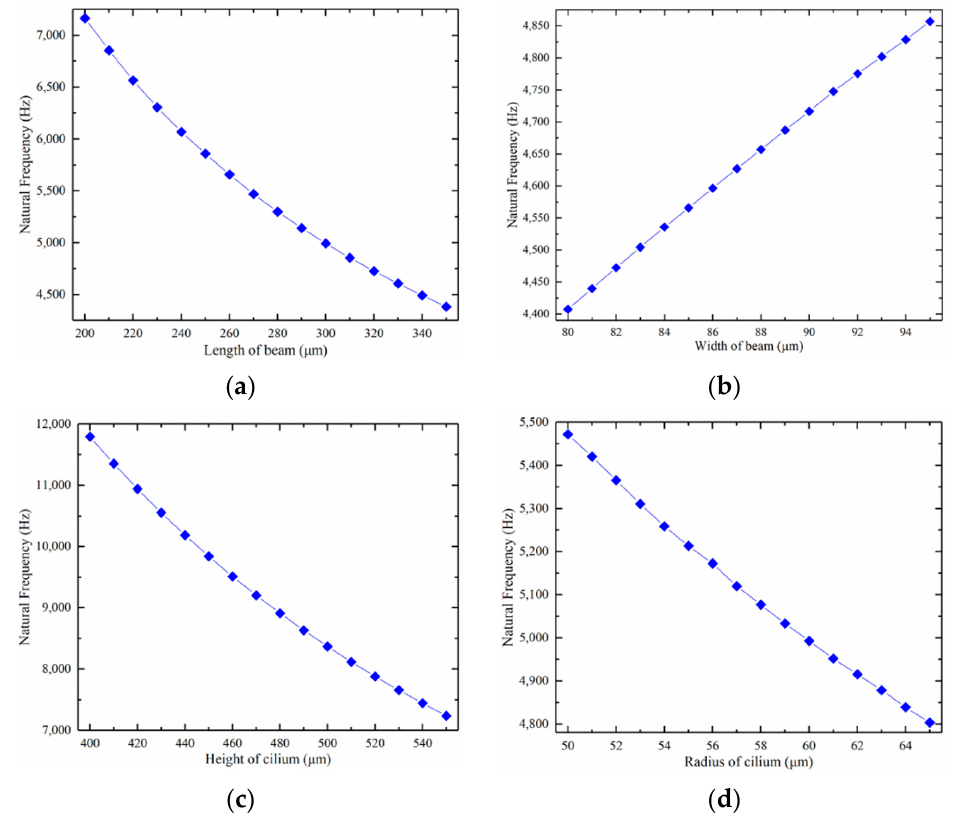
Figure 8. The impact of different structural parameters on the natural frequency: ( a ) beam length’s impact; ( b ) beam width’s impact; ( c ) cilium height’s impact; ( d ) cilium radius’ impact. Natural frequency is positively correlated with beam width but negatively correlated with beam length, cilium radius, and height.